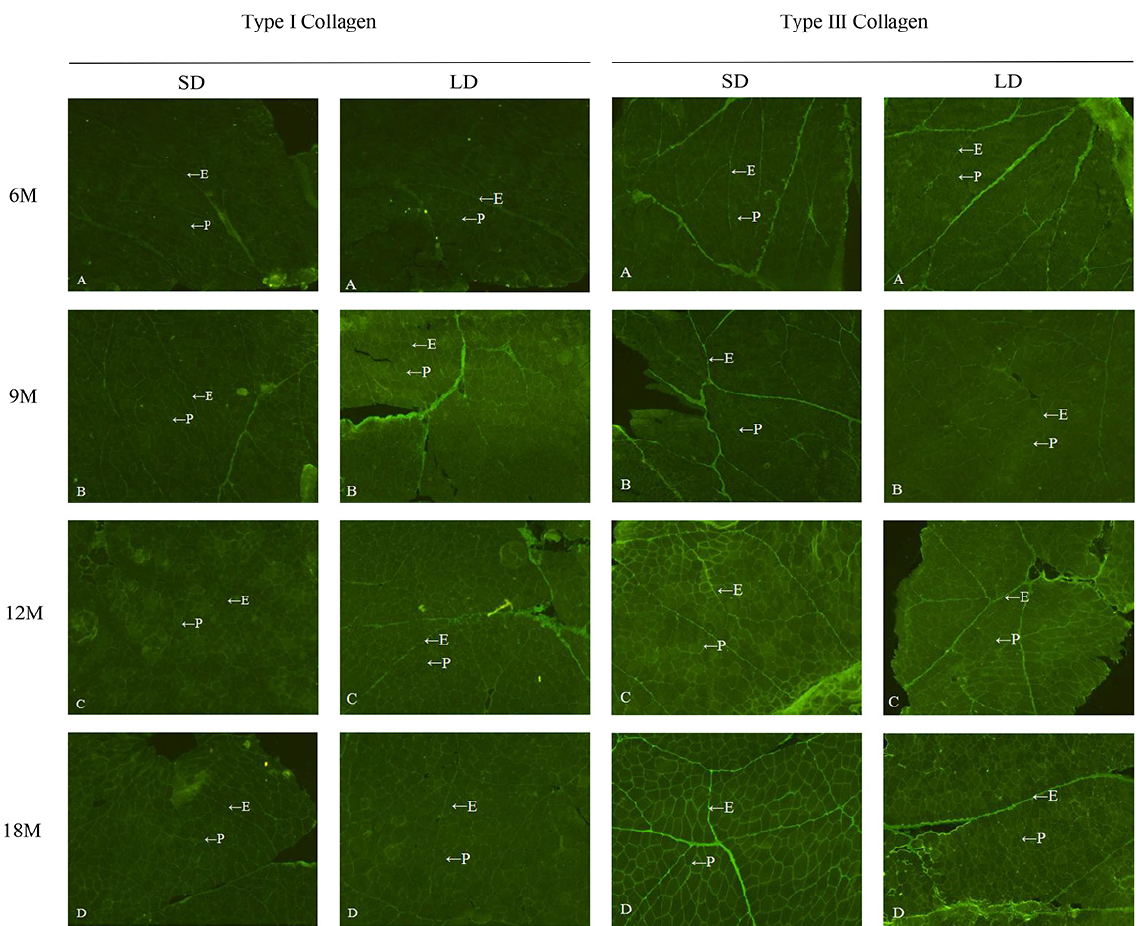
Figure 2. Distribution of type ( Ⅰ , Ⅲ ) collagen in semitendinosus (SD) and longissimus dorsi (LD) muscles at different growth stages. The endomysium is represented by E, perimysium by P, and ( A , B , C , D ) represent 6 (6 M), 9 (9 M), 12 (12 M), and 18 (18 M) months of age, respectively. Magnification is 10×.